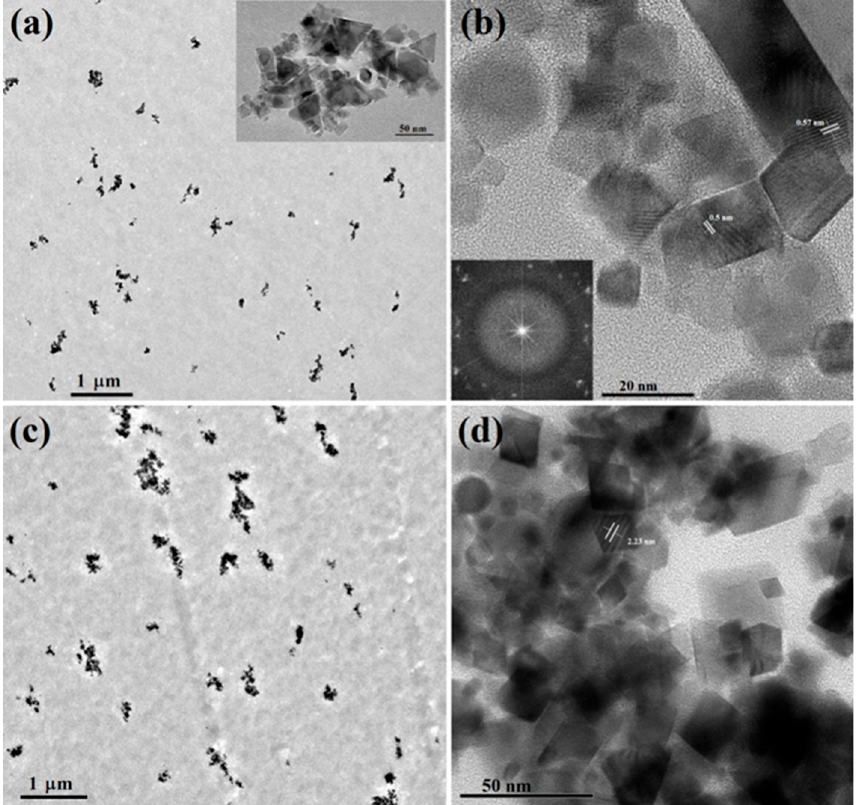
Figure 6. Transmission electron microscopy (EM) images of CACe-1 ( a , b ) and CACe-5 ( c , d ) nanocomposites. The inset of image ( b ) shows the corresponding SAED pattern.